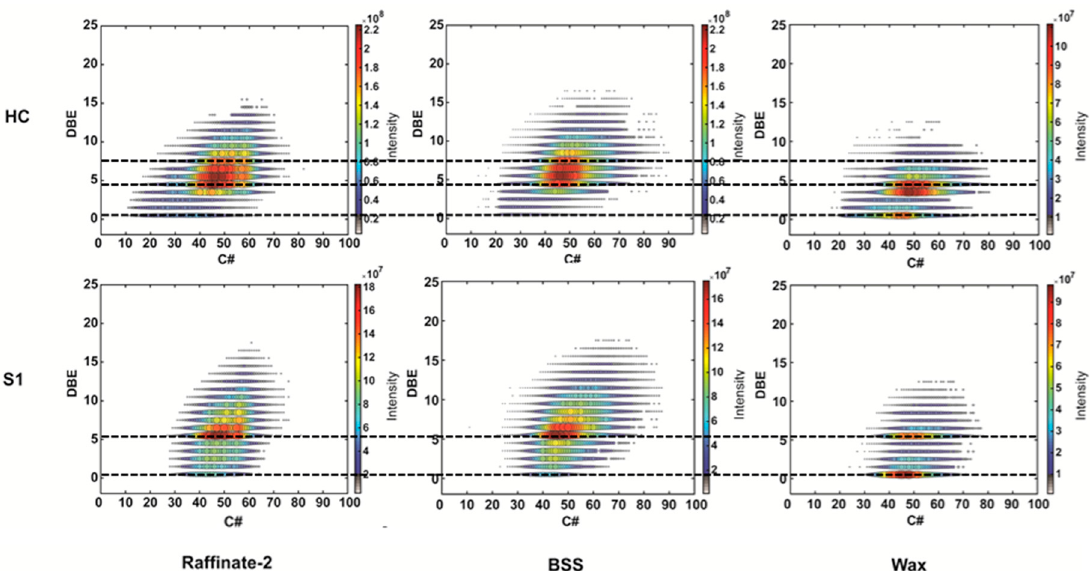
Figure 9. DBE / C# maps of the HC and S 1 chemical classes of proton species detected in atmospheric pressure chemical ionization (APCI)+ in raffinate 1, solvent extracted bright stock (BSS), and wax for the DEWAXING unit.